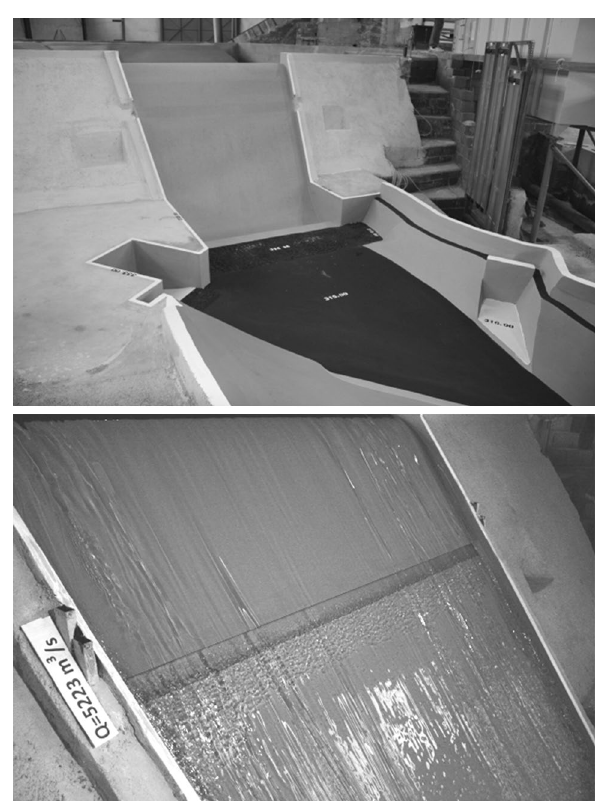
Fig. 2 Visuals from the physical model setup (Özcan